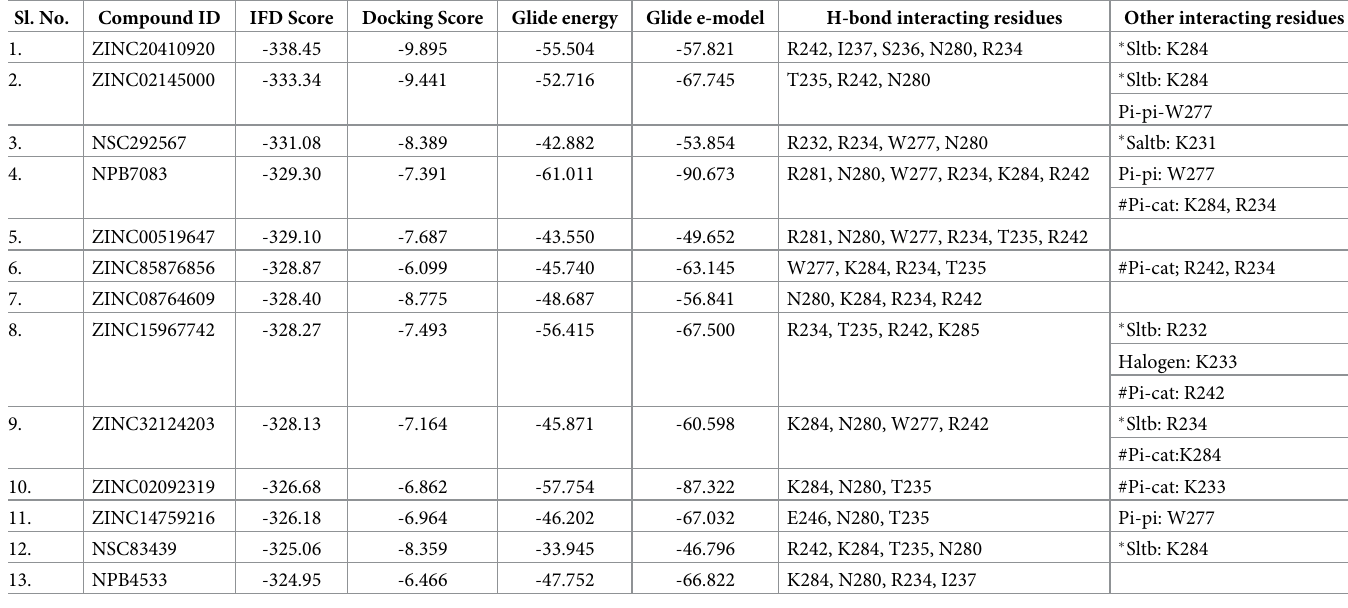
Table 3. Induce fit docking results of top thirteen screened potential compounds with different score and interactions with protein. Sl.